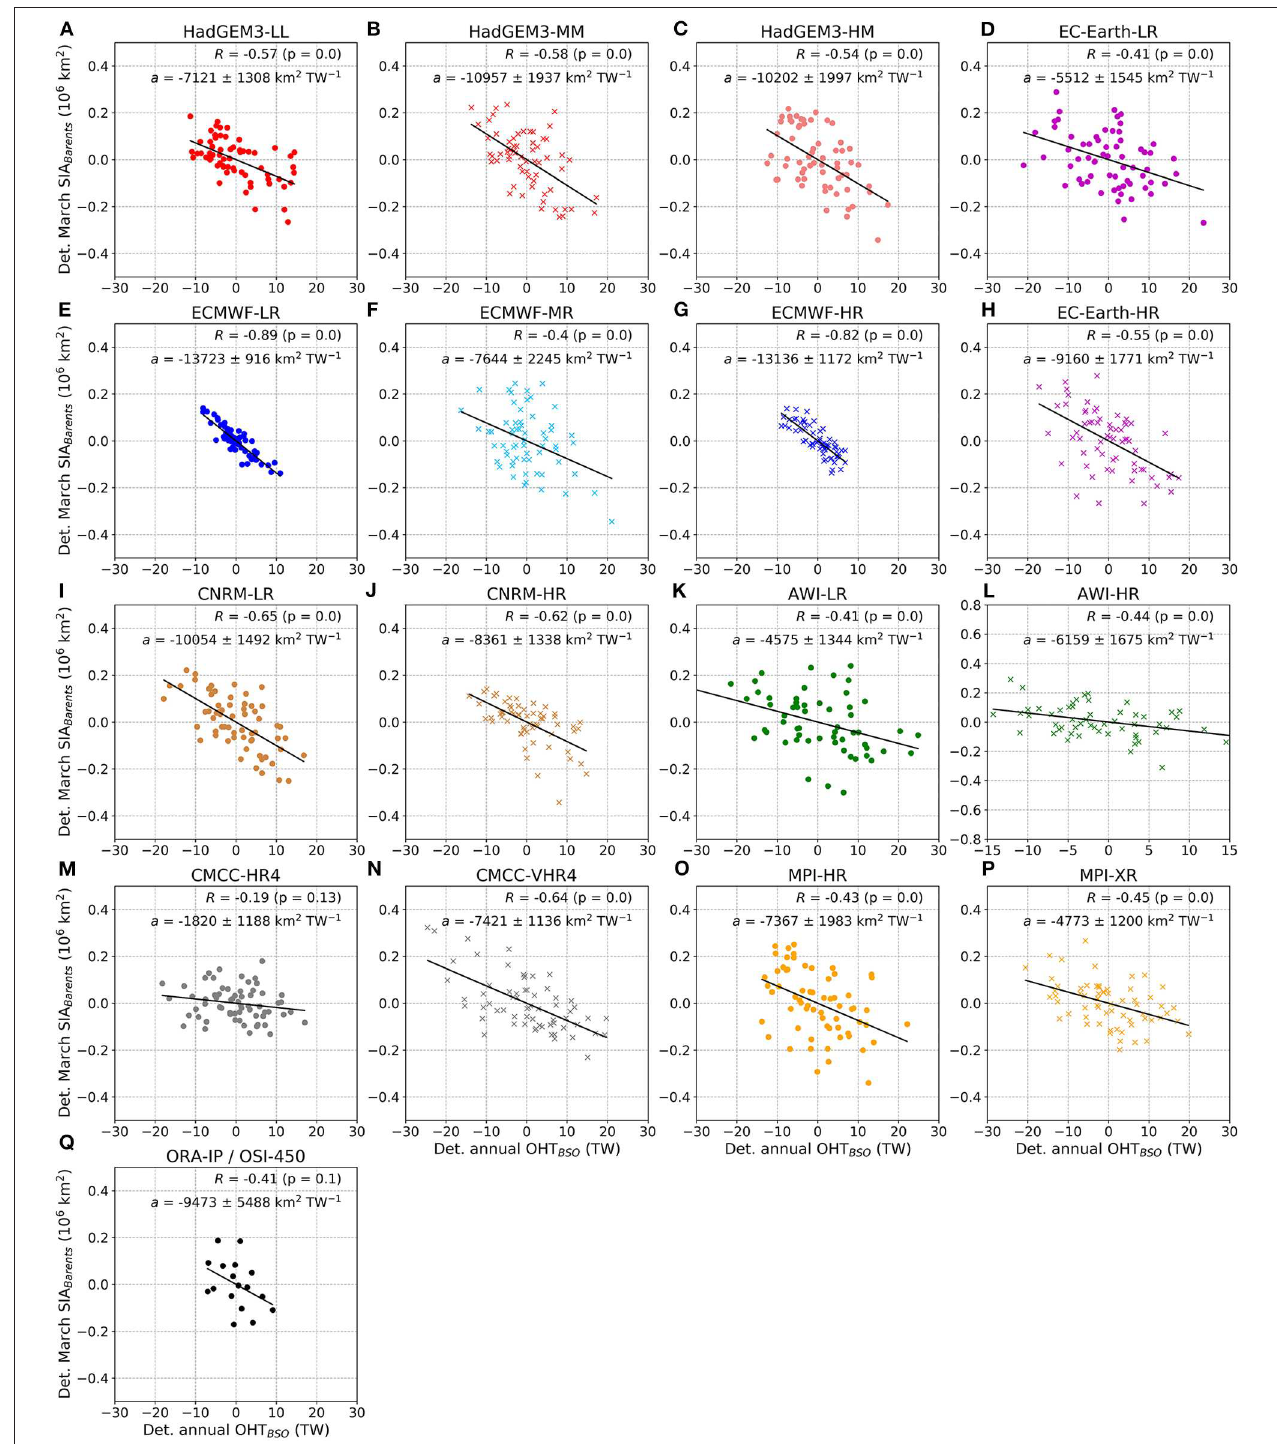
FIGURE 9 | Scatter plots of detrended mean March Barents sea-ice area (SIA Barents ) against detrended annual mean ocean heat transport (OHT) at the Barents Sea Opening (large OHT BSO transect) in (A–P) HighResMIP hist-1950 model outputs and (Q) reanalysis/observations, with OHT leading SIA by 1 year. All yearly values between 1950 and 2014 (1993–2010 for ORA-IP reanalyses/OSI-450 observations) are plotted. Correlation coefficients R and regression slopes a (with their respective p -value and standard deviation) are indicated in the upper right corner of each